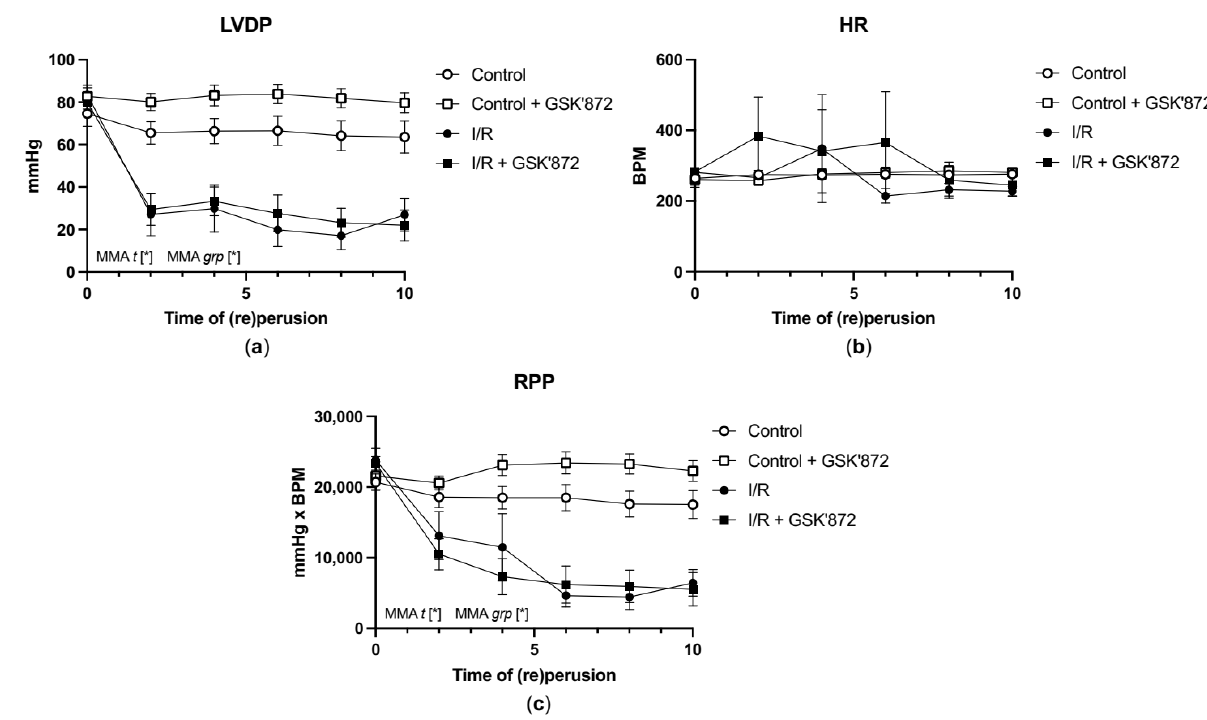
Figure 3. Time-course of the selected hemodynamic parameters of the heart. ( a ) LVDP, ( b ) HR, ( c ) RPP. Data are presented as mean ± SEM; * p < 0.05. MMA—mixed-model ANOVA; t —time; grp